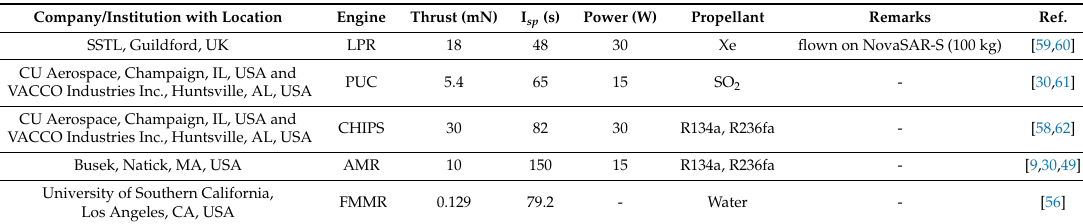
Table 4. Summary of Resistojet Propulsion